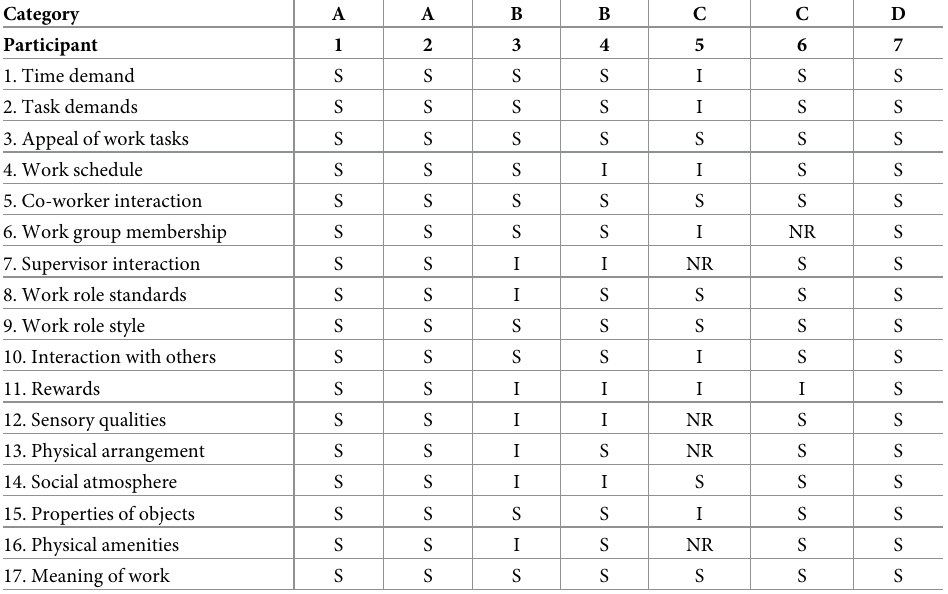
Table 5. Rating for each item on The Work Environment Impact Scale (WEIS) in the four categories of the partic- ipants (n = 7).